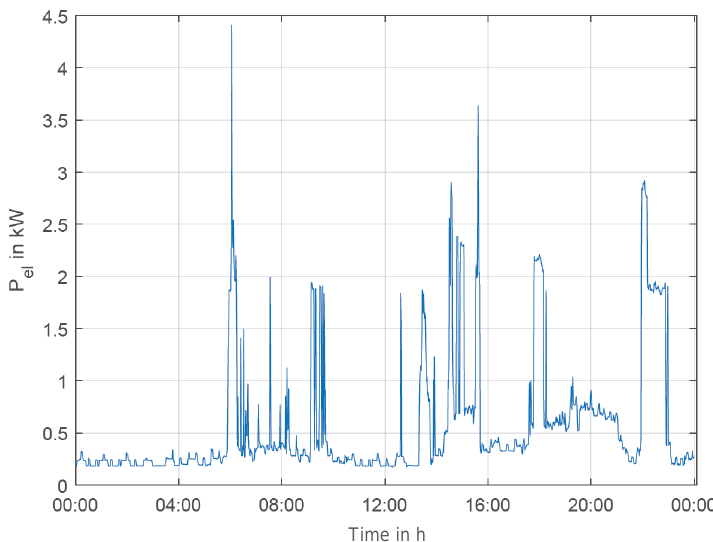
Figure 12. Exemplary electrical load profile for the demand of a 3-person residential home in Germany with a daily consumption of 13.7 kWh during a winter day, based on reference load profiles VDI 4655-Blatt 1